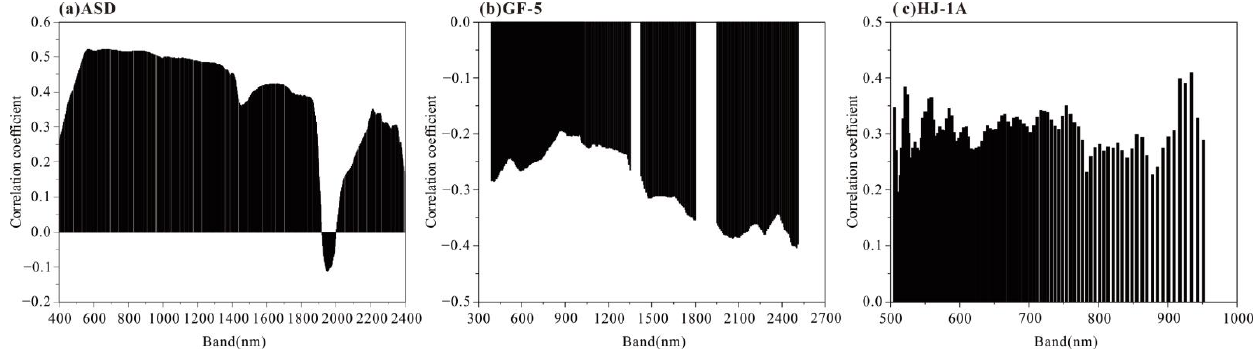
Figure 6. The Pearson correlation coefficient between EC and reflectance of ASD ( a ), GF-5 ( b ), and HJ-1A ( c ) spectra.